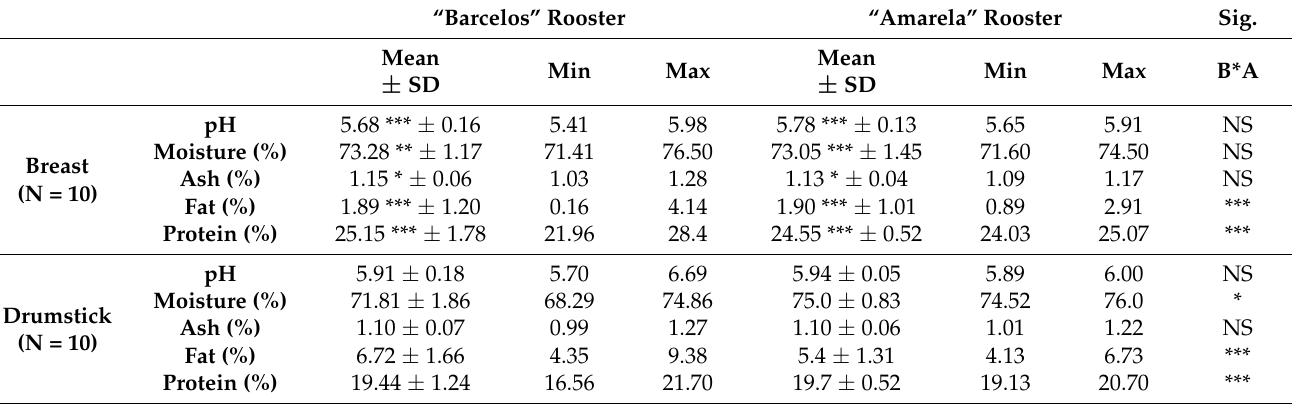
pH (5.80 vs. 5.90), moisture (72.54 vs. 74.60%), ash (1.13 vs. 1.12%), total fat content (4.31